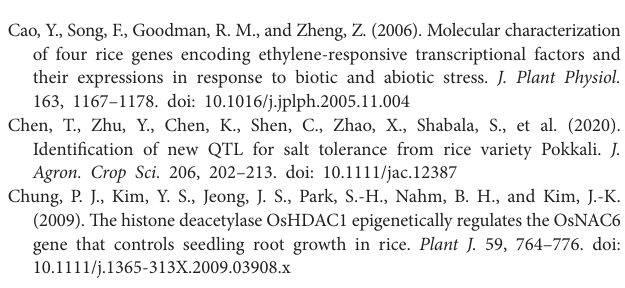
Supplementary Figure S1 | QQ plots of genome-wide association studies for the eight traits related to ST. A-H: QQ plots for RNC, SKC, SNC, RN/K, RTRL, RTRSA, RTRV, and RSN/K. Supplementary Figure S2 | (A–C) DNA sequence analysis and amino acid sequence analysis for three candidate genes. Supplementary Figure S3 | Expression profiles in rice seedling under the various environmental